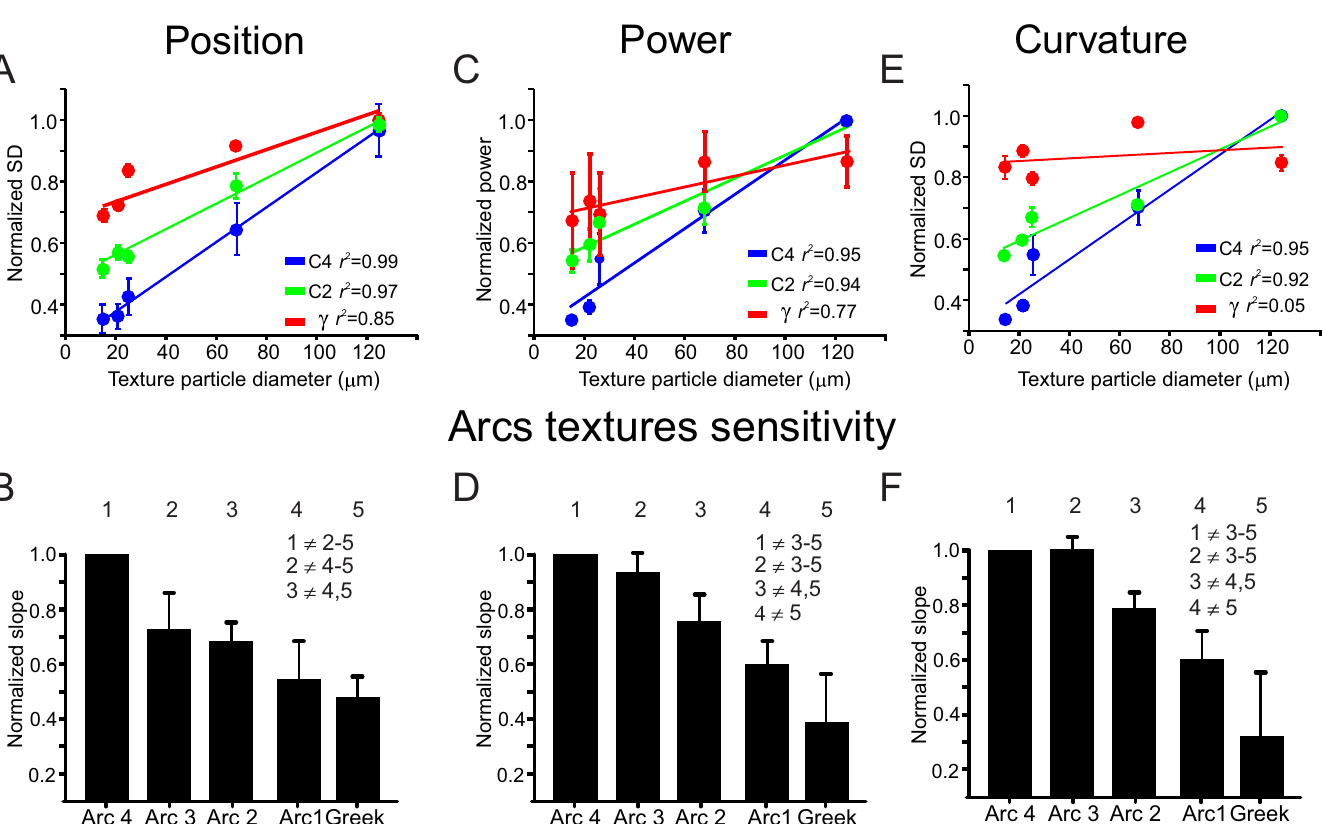
Fig 3. Rostral whiskers exhibit higher response sensitivity to texture grain. (A, C, E) Linear regression fit of the normalized SD (A), power (C), and curvature (E) of whisker vibrations in response to several textures ( n = 5; each texture is represented by the mean particle size). (B, D, F) Normalized slopes (normalized to the slope of arc 4 whiskers of each session) of the linear regression fit for all whiskers. The numbers indicate the different arcs. The inequality sign indicates a statistically significant difference between the various arcs. The underlying data for this Figure can be found in S1 Data.